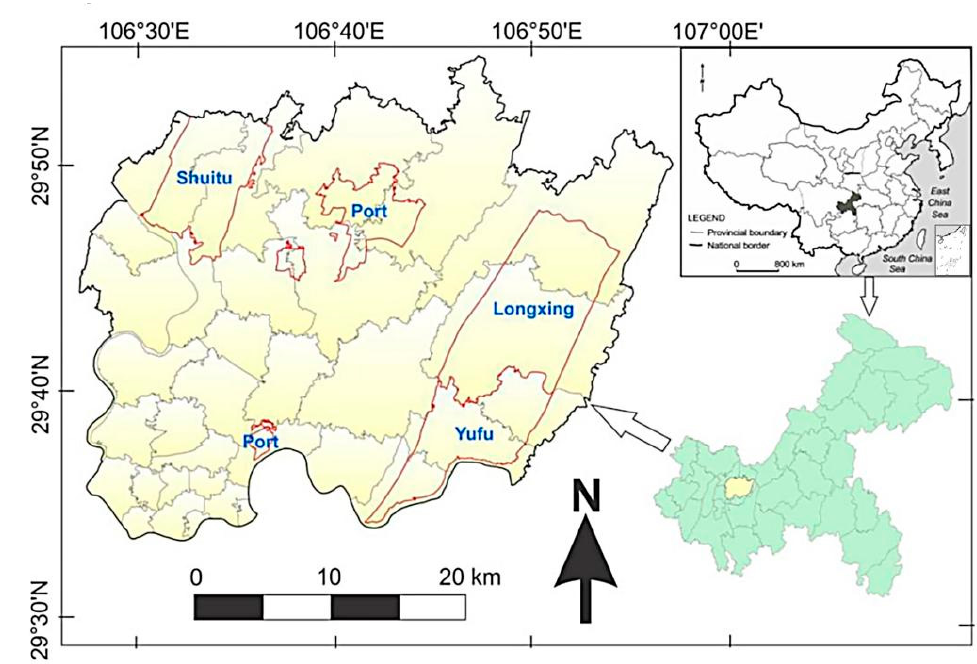
Figure 1. Study area: the Liangjiang New District, Chongqing, Southwest China. Red lines: bound- aries of industrial zones and duty-free ports; grey lines: county boundaries. Table 1. Variables considered in the modeling.